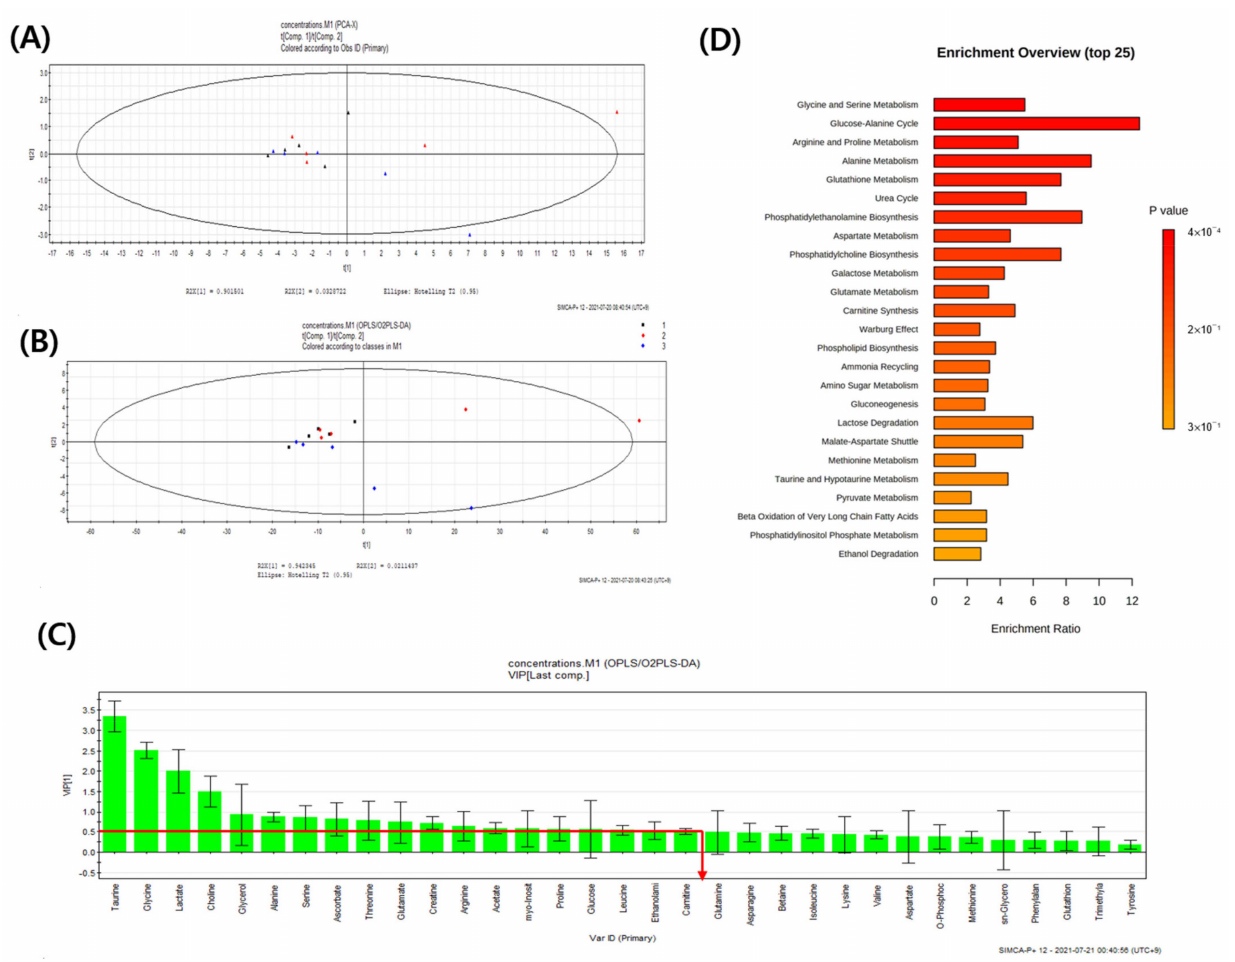
Figure 4. Pattern recognition of lung metabolomics profiles using 1 H-NMR spectroscopy. ( A ) Principal component analysis (PCA) (R 2 X = 0.997, Q 2 = 0.903) and ( B ) orthogonal projections to latent structures-discriminant analysis (OPLS-DA) (R 2 X = 0.963, Q 2 = 0.201) models results after NMR analysis of control, positive control and test group in serum samples. ( C ) Variable importance plot (VIP) shows the major serum metabolites that contributed to separate the clusters (VIP ≥ 0.5) and ( D ) Metabolites set enrichment overview ( n = 5); (cid:78) , control (CON); , positive control (PC); , test (SS).